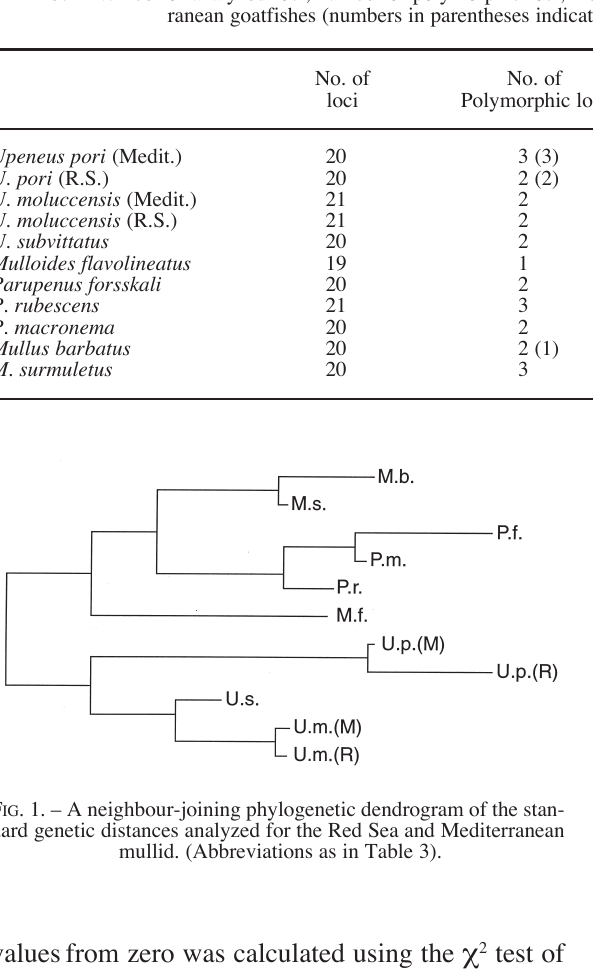
six polymorphic loci was 0.1171. The effective number of migrants between popula- tions is estimated as 1.89 individuals per generation. For U. moluccensis , the mean F over the two poly- ST morphic loci was 0.0720. The effective number of migrants between populations is estimated as 3.22 individuals per